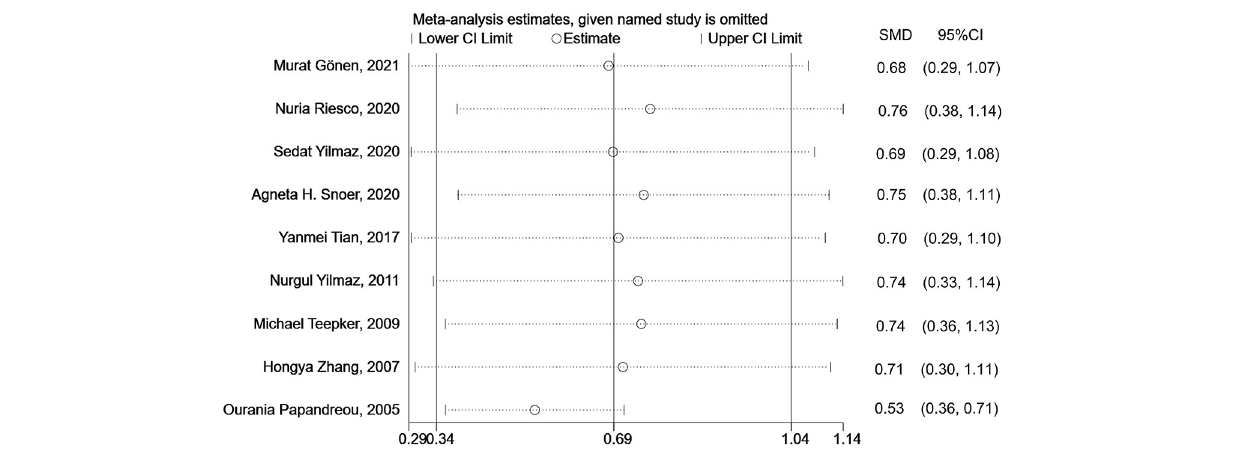
Therefore, in the future, age stratification is needed to explore the elevated S100B levels in patients with